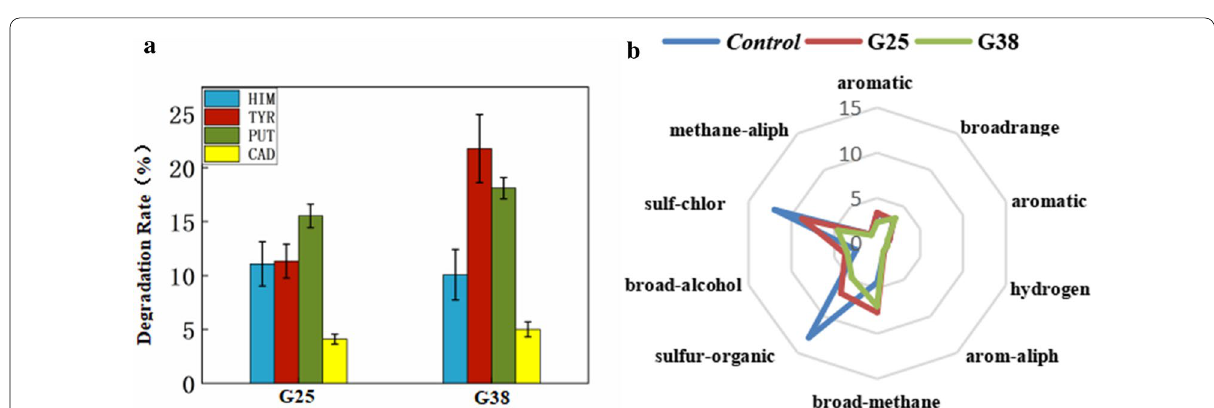
standard deviations from three determinations: a Degradation of BAs in ±